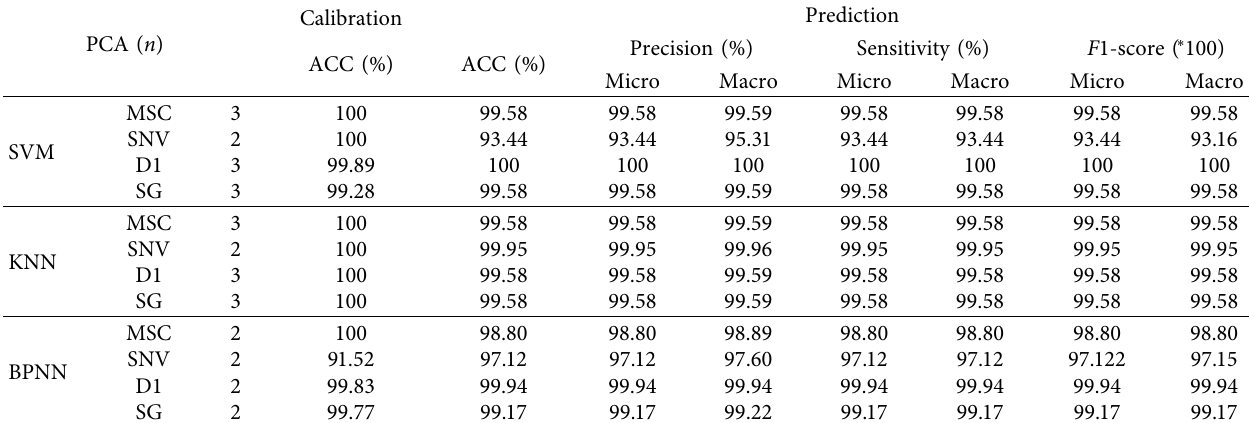
Table 4: Performance of classification models for white commercial plastic